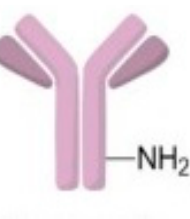
Figure 2. Plans for the bioreactor ( A ); photo of the empty bioreactor ( B ); bioreactor with tubing connection ( C ); and bioreactor filled with culture medium ( D ).